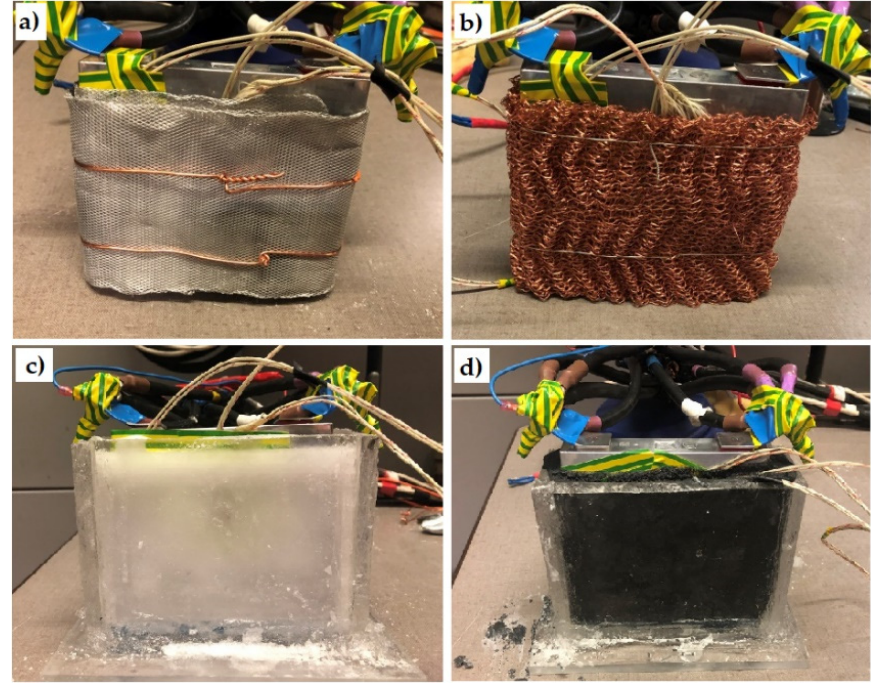
Figure 16. Thermal performance of various scenarios for high power LTO cell: ( a ) Al mesh; ( b ) copper mesh; ( c ) phase change materials (PCM); and ( d ) hybrid PCM-graphite [89].